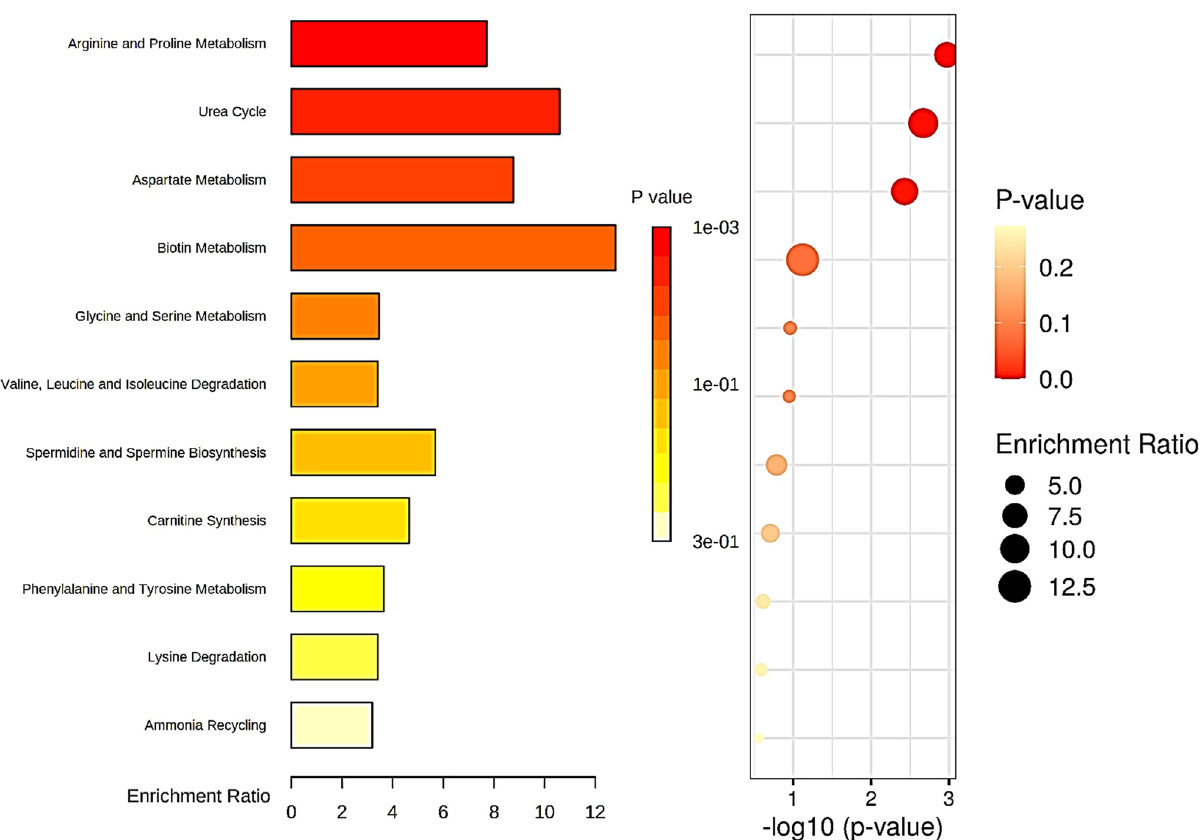
Figure 4. Top enrichment analysis for Arg, Asn, Cit, Ile, Leu, Lys, Orn, Phe, Pro, and Ser. Analysis was performed in Metaboanalyst with those AAs listed as metabolites within the Human Metabolome Database HMDB and showed significant alteration in 11 pathways in triple negative MD-MBA-231 breast cancer xenograft model. The three most significant biological pathways enriched include Arg and Pro metabolism ( p = 0.00107); Urea Cycle ( p = 0,00,215) and Asp metabolism ( p = 0.00373) followed by Biotin metabolism ( p = 0.0758); Gly and Ser metabolism ( p = 0.109); Val, Leu and Ile degradation ( p = 0.112); Spermidine